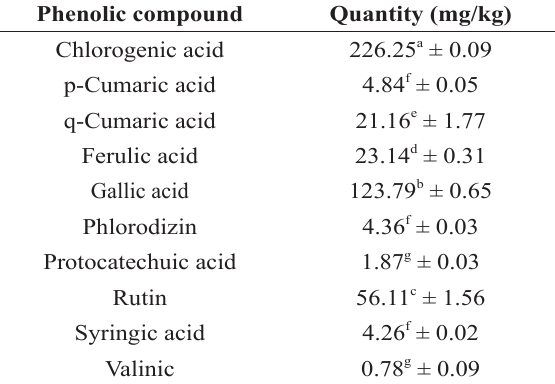
Different phenolic compounds of